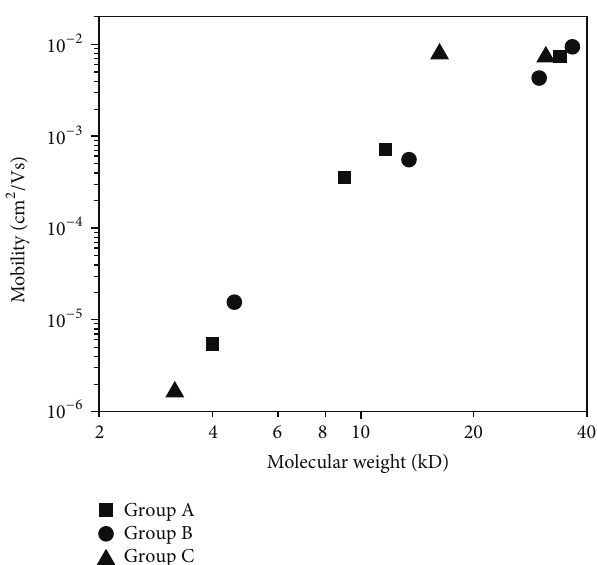
Figure3:Field-effectmobilityversusthenumberaveragemolecular weight [50].